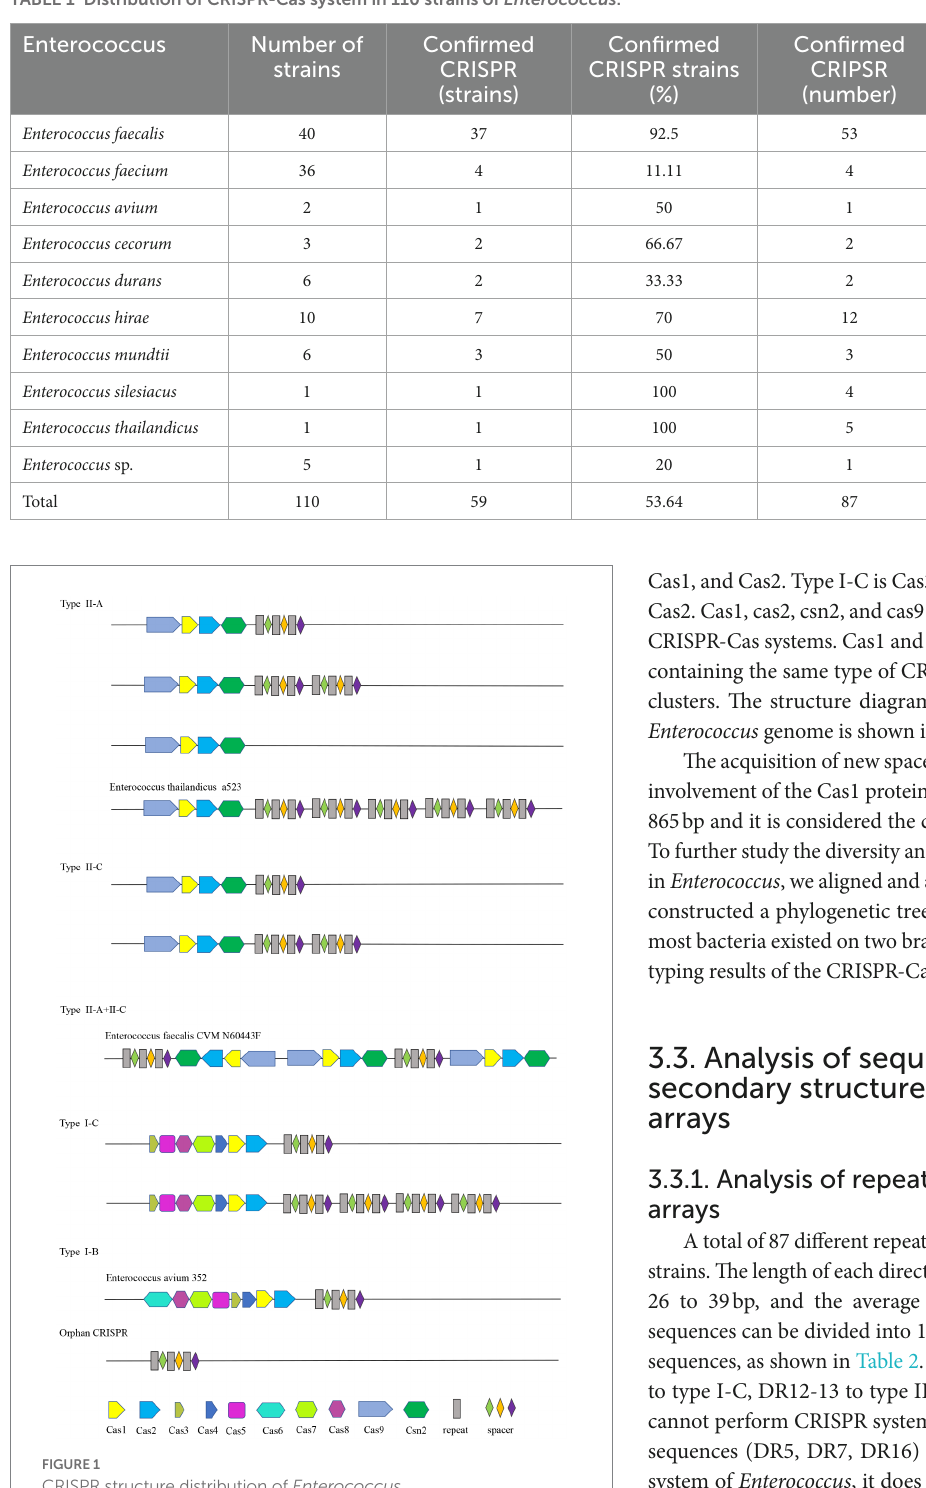
FIGURE 1 CRISPR structure distribution of Enterococcus